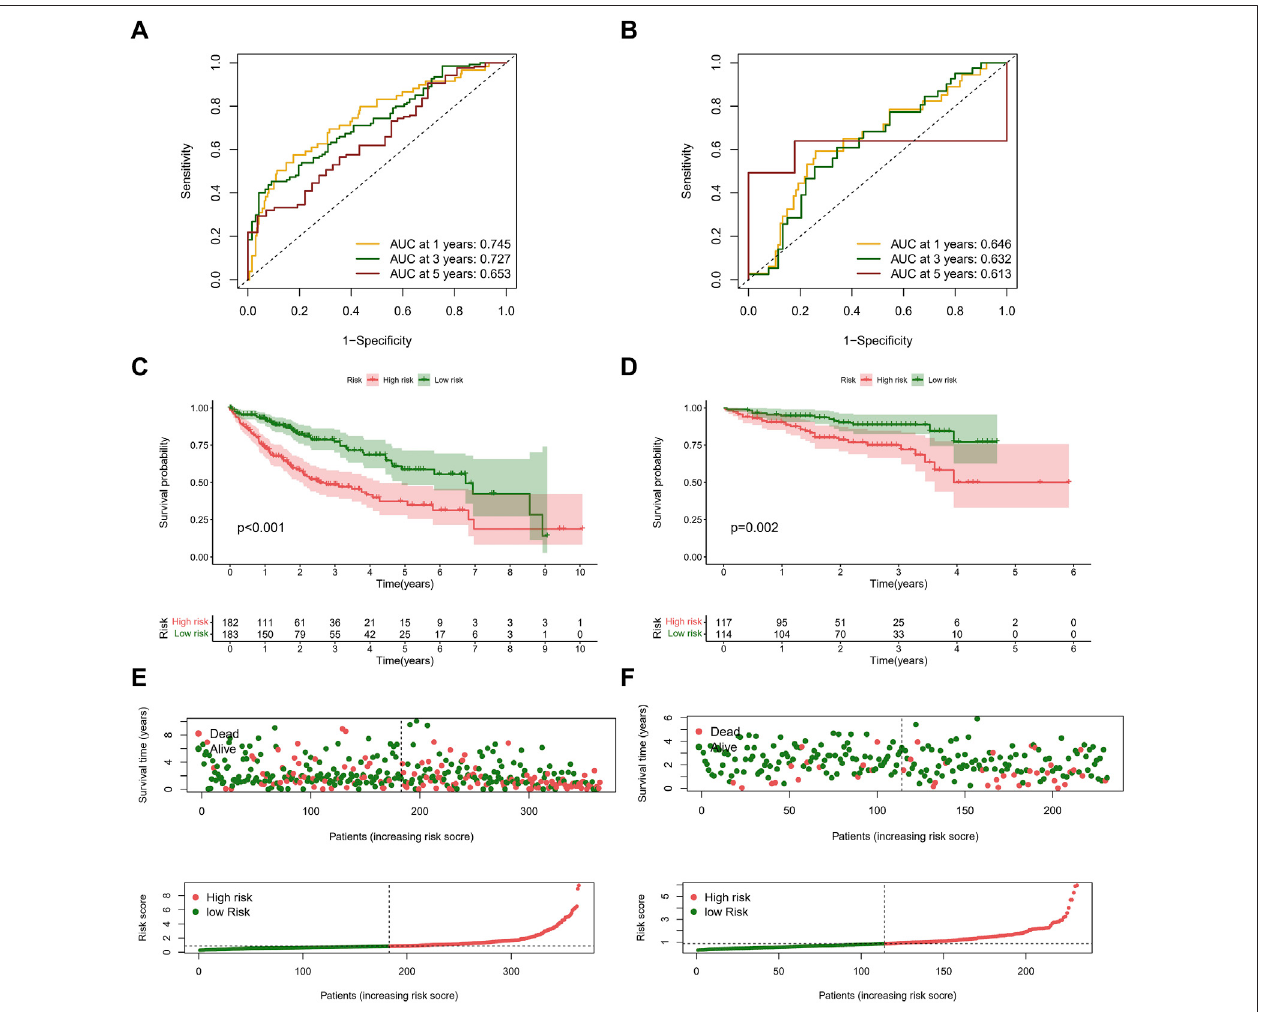
FIGURE 5 | Evaluation of prognostic signature in the TCGA and ICGC cohorts. (A) ROC curves of the NRLs signature in the TCGA cohort. The AUCs of 1, 3, and 5 years OS were 0.745, 0.727, and 0.653. (B) ROC curves of the NRLs signature in the ICGC cohort. The AUCs of 1, 3, and 5 years OS were 0.646, 0.632, and 0.613. (C,D) Kaplan – MeiersurvivalcurvesofOS(survivalprobability)ofpatientsbetweendifferentriskgroupsintheTCGA (C) andICGC (D) cohorts. (E,F) Scatterplot(up)and curve plot (down) of risk score in the TCGA (E) and ICGC (F)